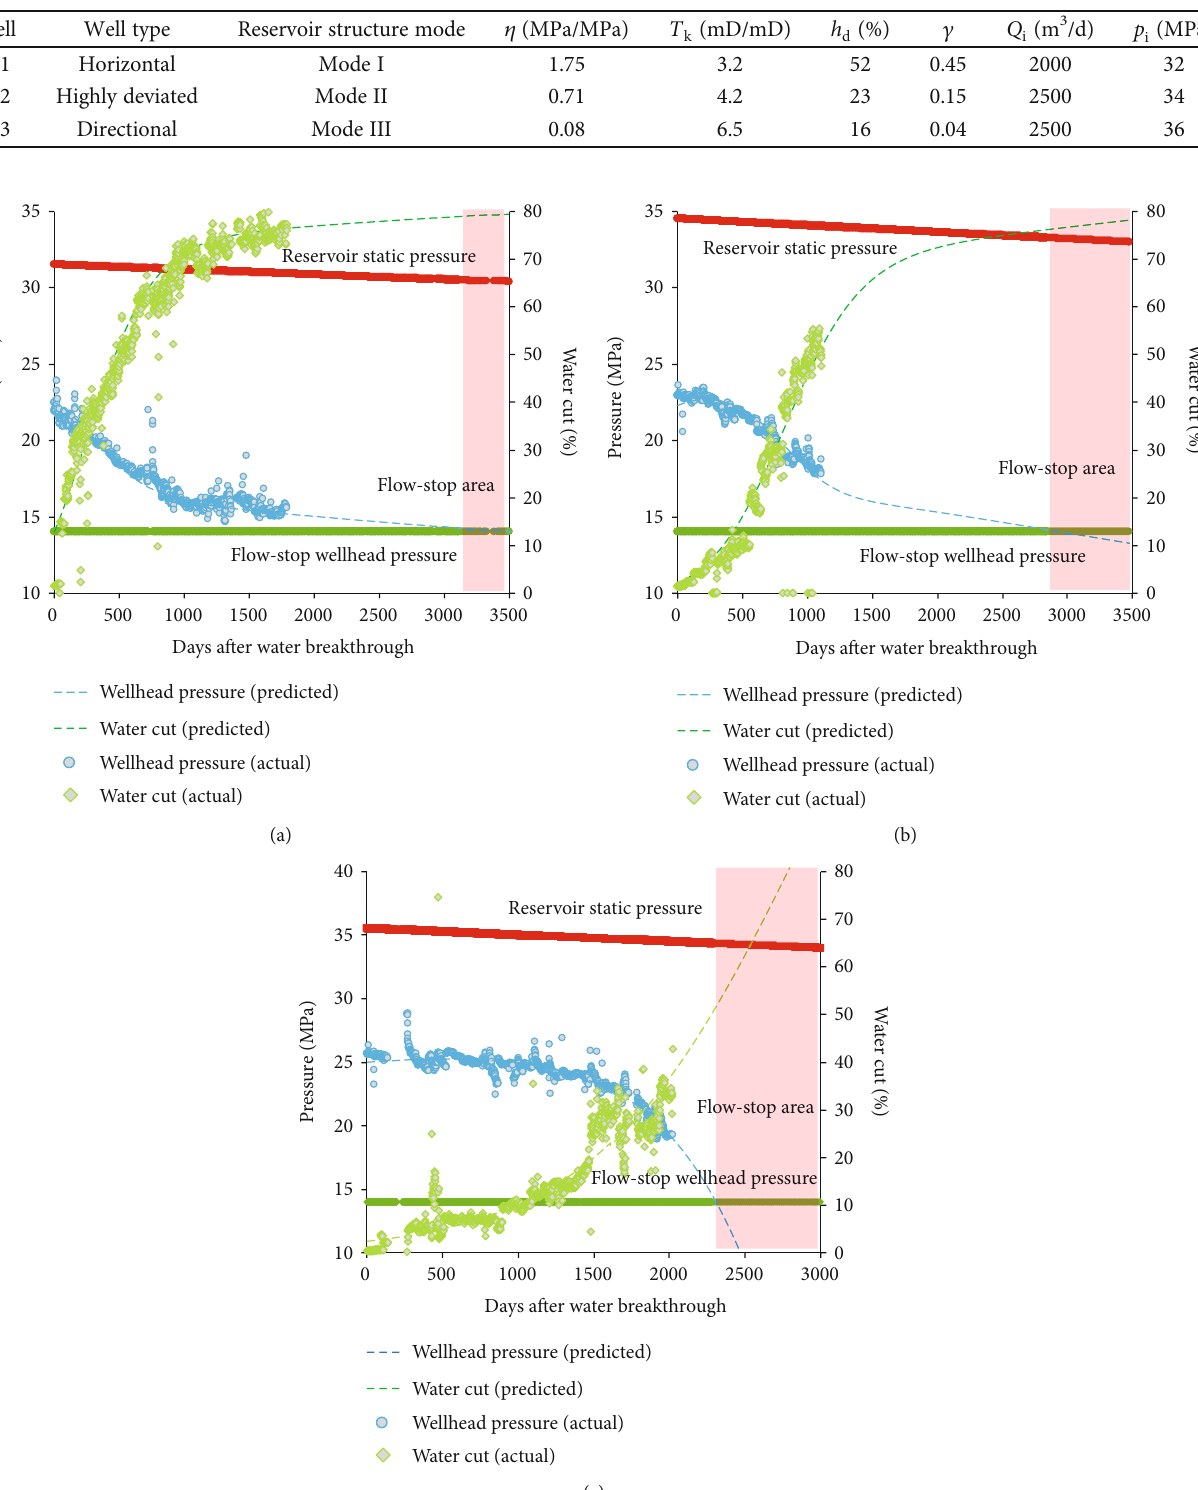
Table 7: Information of J-01/02/03.